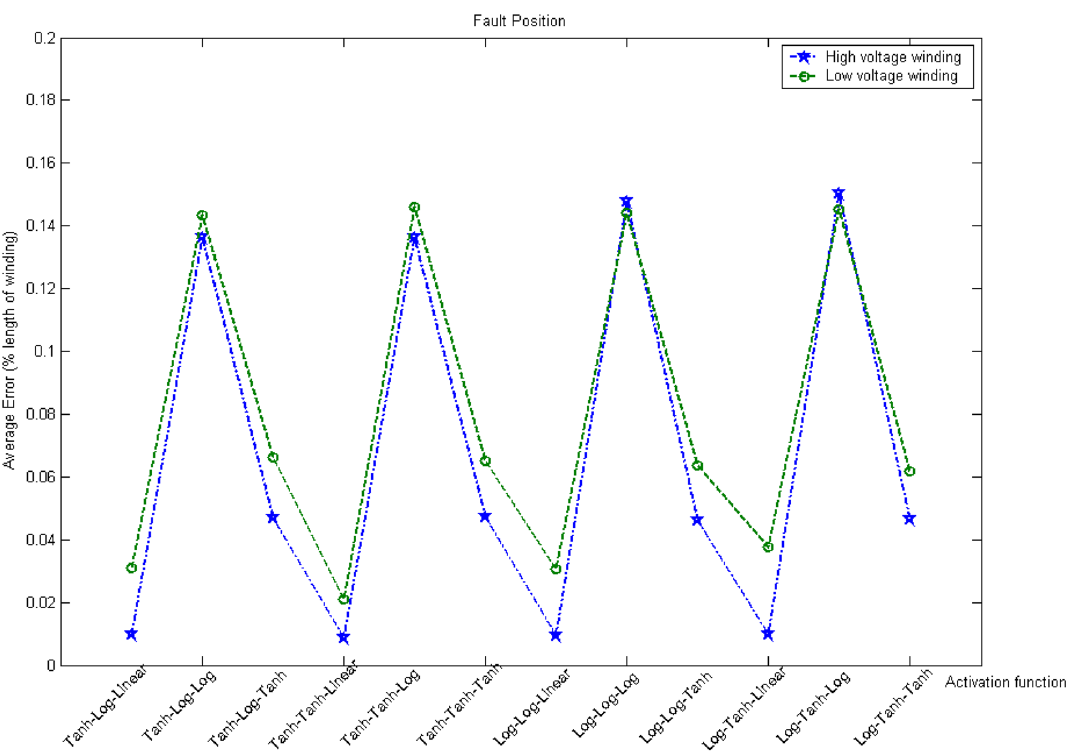
Figure 11. Average errors in fault location for different combinations of activation functions.